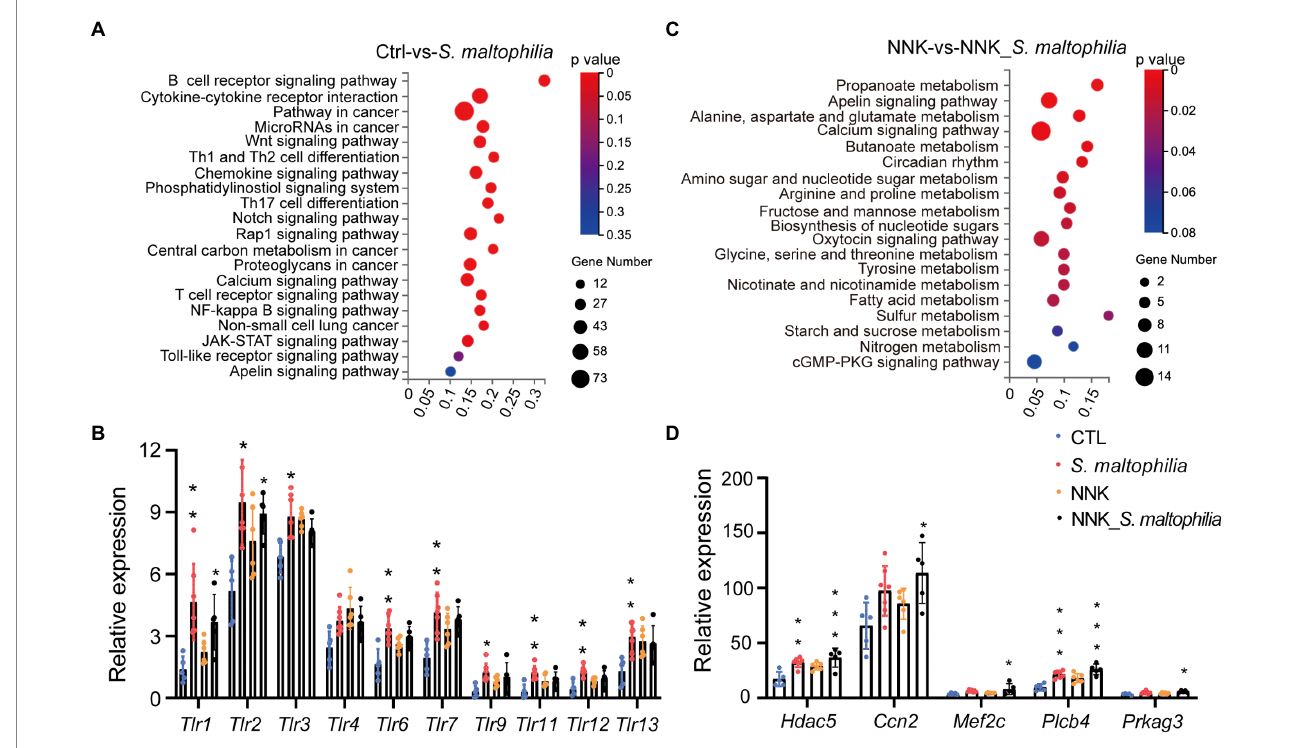
FIGURE 4 Stenotrophomonas maltophilia modulates gene expression in lung tissues by RNA-seq analysis. (A) KEGG pathway enrichment analysis of upregulated genes of RNA-seq data between CTL and S . maltophilia groups. (B) Relative expression of Toll-like receptors. (C) KEGG pathway enrichment analysis of upregulated genes of RNA-seq data between NNK and NNK_S. maltophilia groups. (D) Relative expression of Apelin signaling pathway genes. * p < 0.05, ** p < 0.01, *** p < 0.001, compared with